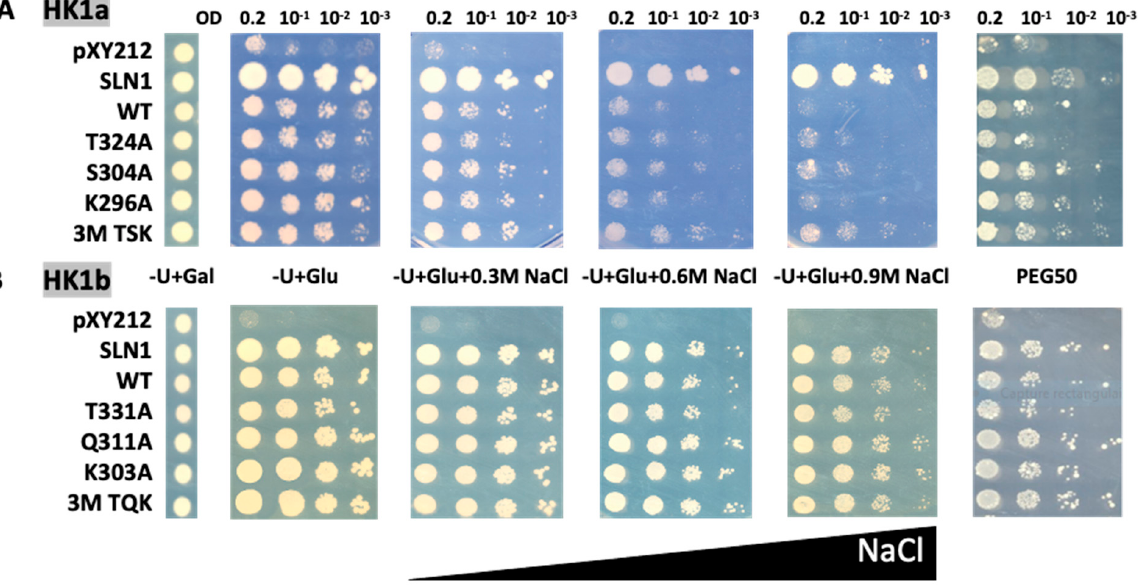
Figure 3. Functional complementation test for cache mutants of HK1a ( A ) and HK1b ( B ) in presence of NaCl or PEG 6000 stresses. The osmodeficient strain (MH179) was transformed with the negative (pYX212 empty vector) and positive (SLN1) controls, as well as with wild type constructs (WT) and single point mutation constructs of HK1a (T324A, S304A, K296A) and HK1b (T331A, Q311A, K303A), or triple point mutation constructs of HK1a (3M TSK) and HK1b (3M TQK). Transformants were spotted onto galactose containing medium ( − U + Gal) for growth control and onto glucose containing medium, without ( − U + Glu) or with increasing NaCl concentrations (0.3, 0.6 and 0.9 M), or infused PEG 6000 50% w / v (PEG50), for osmotic tolerance test. Growth tests are representative of four independent replicates as serial 10-fold dilutions from an OD 600 = 0.2, as indicated.